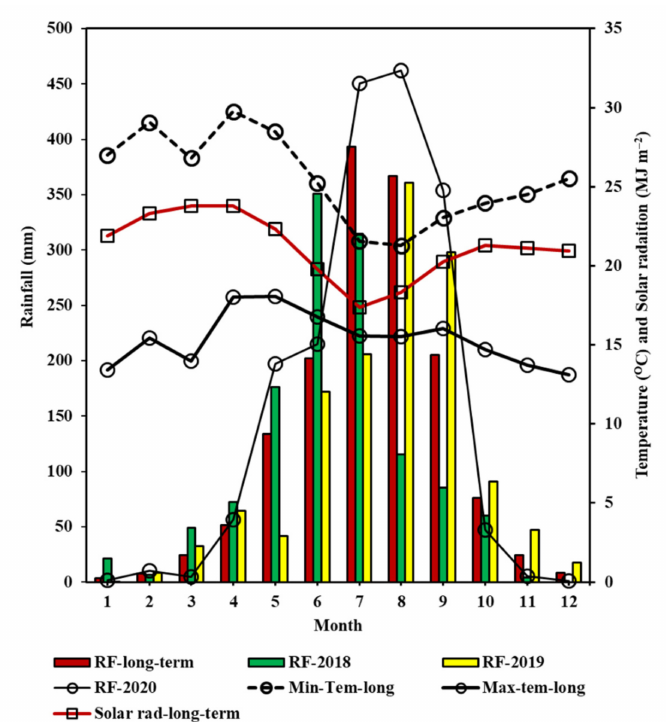
Figure 1. Long-term (2000–2020) average monthly rainfall (RF-long-term), maximum temperature (Max-tem-long), minimum temperature (Min-tem-long), and solar radiation (Solar rad-long-term) in the study area. The total monthly rainfall for the present study period (RF-2018, RF-2019 and RF-2020) is also